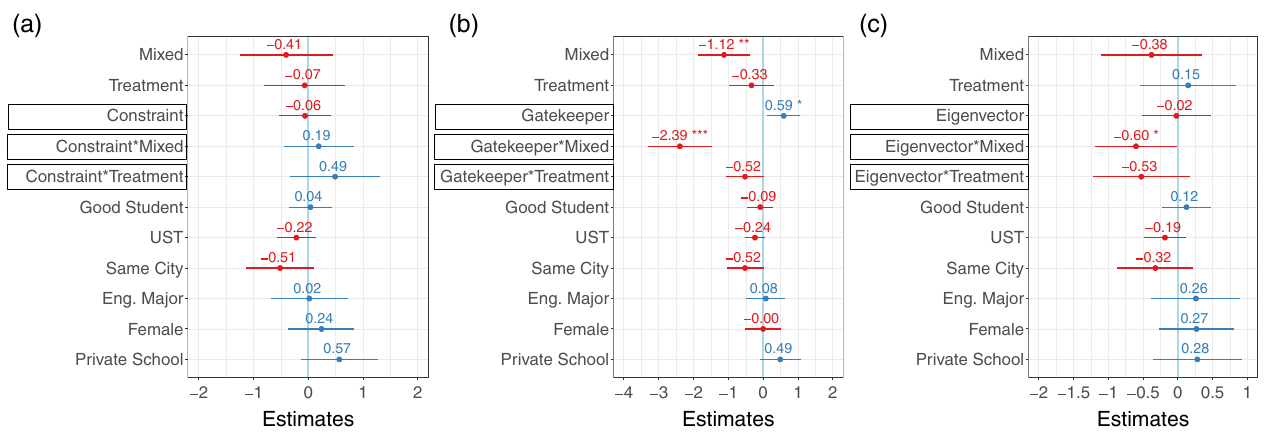
FIG. 6. Graphical depiction of OLS multiple regression models for problem elaboration regressed on network predictors, controlling for confounding variables (see Table 1 in the Supplemental Material [41], results section). Red indicates a negative effect and blue indicates a positive effect. One star (*) indicates significance at a level of p value < 0 . 05 and two stars (**) indicate significance at a level of p value < 0 . 01